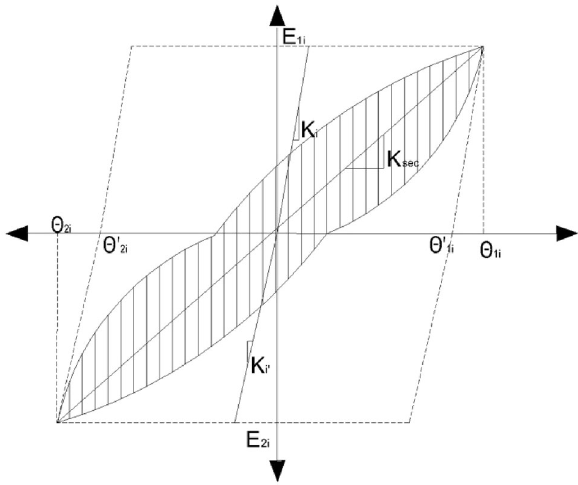
Fig. 22 Calculation of secant stiffness (K sec ) for test specimens.